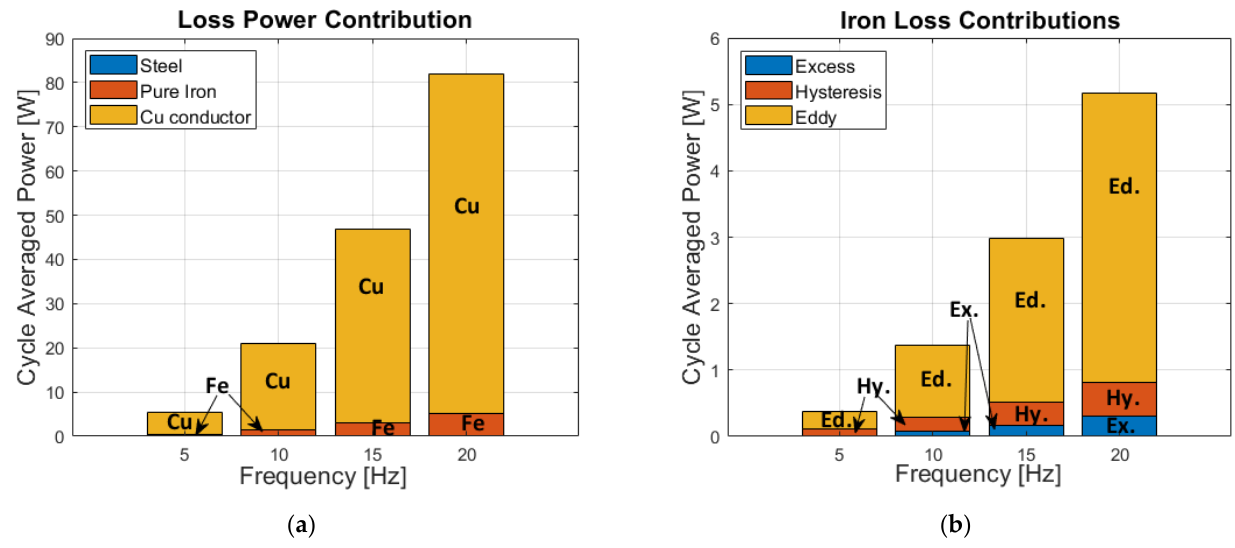
Figure 14. Contribution of the power losses for various frequencies in ( a ) the stator materials; ( b ) the soft magnetic materials of the stator.